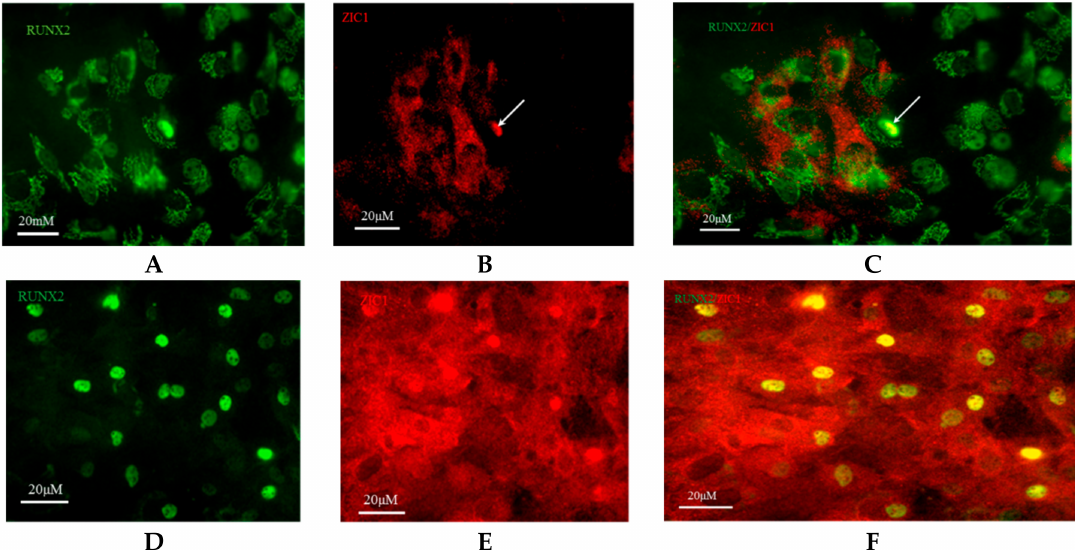
Figure 4. Rat osteoprogenitors (ROPs) cultured in osteogenic medium and maintained as static controls were fixed on 25 mm coverslips and immunostained at the end of day 3 with ( A ) anti-RUNX2 (green fluorescence, plate 1) and ( B ) anti- ZIC1 (red fluorescence, plate 2) antibodies. ( C ) Plates 1 and 2 were merged together to identify co-localisation of RUNX2 and ZIC1 antibodies (Plate 3). In the representative field of vision, many nuclei showed nuclear translocation of RUNX2 , suggesting relevant osteogenic activity in these cells. A few nuclei showed co-localisation of RUNX2 and ZIC1, and it appears that expression of RUNX2 (yellow) was accompanied by some ZIC1 (red/green). The effect of FSS on the intracellular distribution of RUNX2 and ZIC1 in ROPs is seen in ( D ) plate 4 and ( E ) plate 5, respectively. ( F ) Plates 4 and 5 were merged together to identify co-localisation of RUNX2 and ZIC1 antibodies (Plate